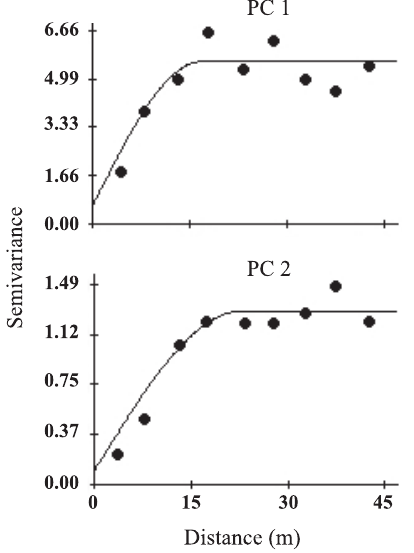
figure 5. variograms adjusted to the principal components (pc1 and pc2).